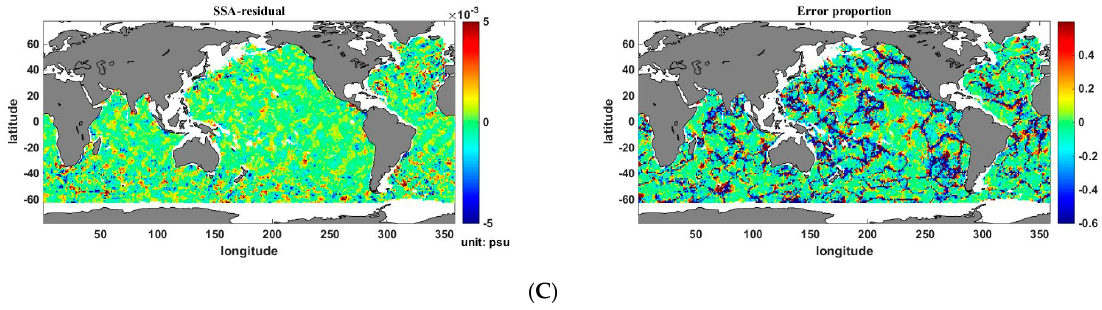
Figure 9. Spatial distribution of the SSA errors (the first column) and the error proportion (the second column) retrieved by the XGBoost method in April 2015 at different depths: ( A ) 100 m, ( B ) 500 m, and ( C ) 1500 m.